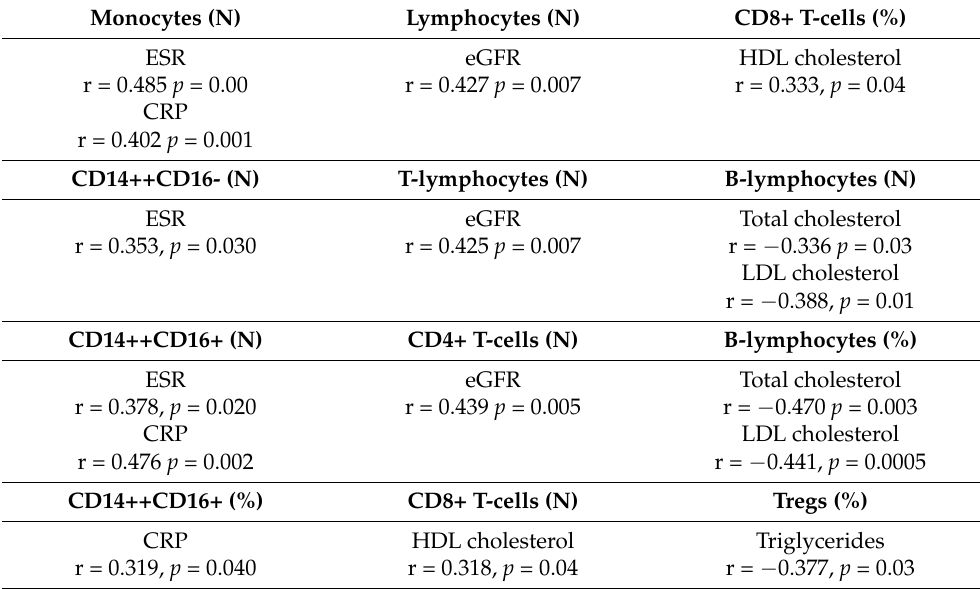
Table 3. Associations of immune cell subpopulations in patients with type 2 CRS with inflammatory markers, eGFR, and serum lipid